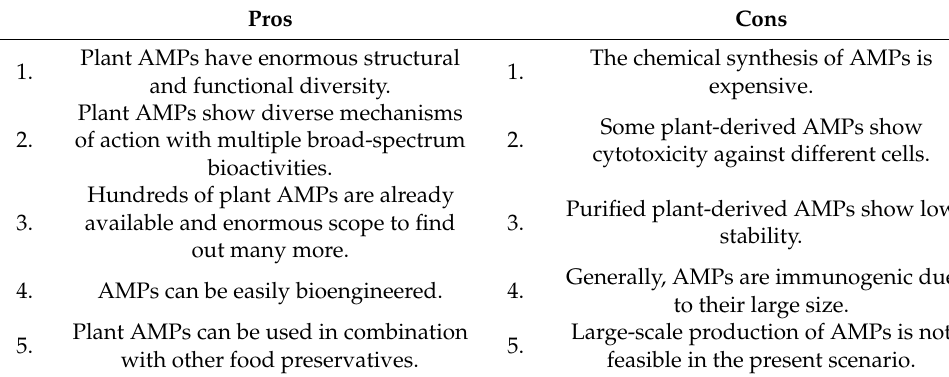
Table 3. Pros and cons of plant AMPs, in terms of their development for application in the food